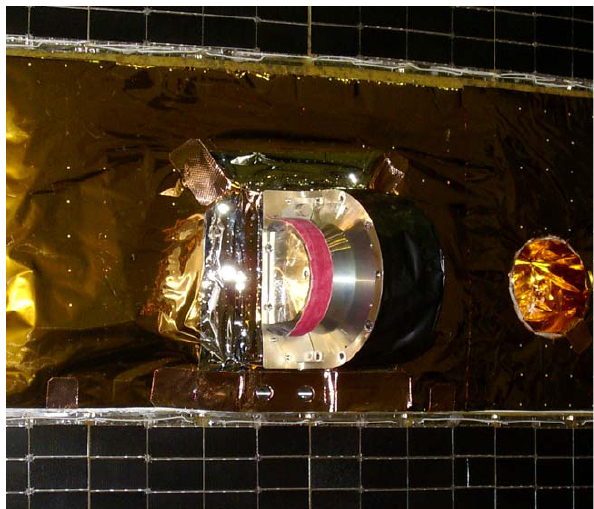
Figure 9. Close up of HEEA Sensor Head showing thermal blanket closeout; note electrically conductive material places over the epoxy used to lock the screw heads.